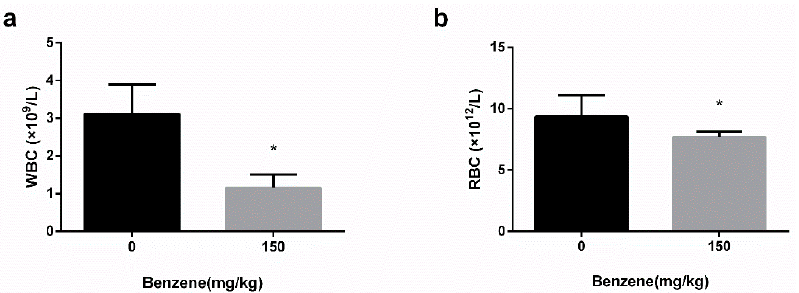
Figure 2. White blood cells (WBC) and red blood cells (RBC) reduced in mice after benzene exposure. ( a ) WBC and ( b ) RBC of mice were measured after daily subcutaneous injection of benzene or corn oil for 15 days. *: p < 0.05, compared with control